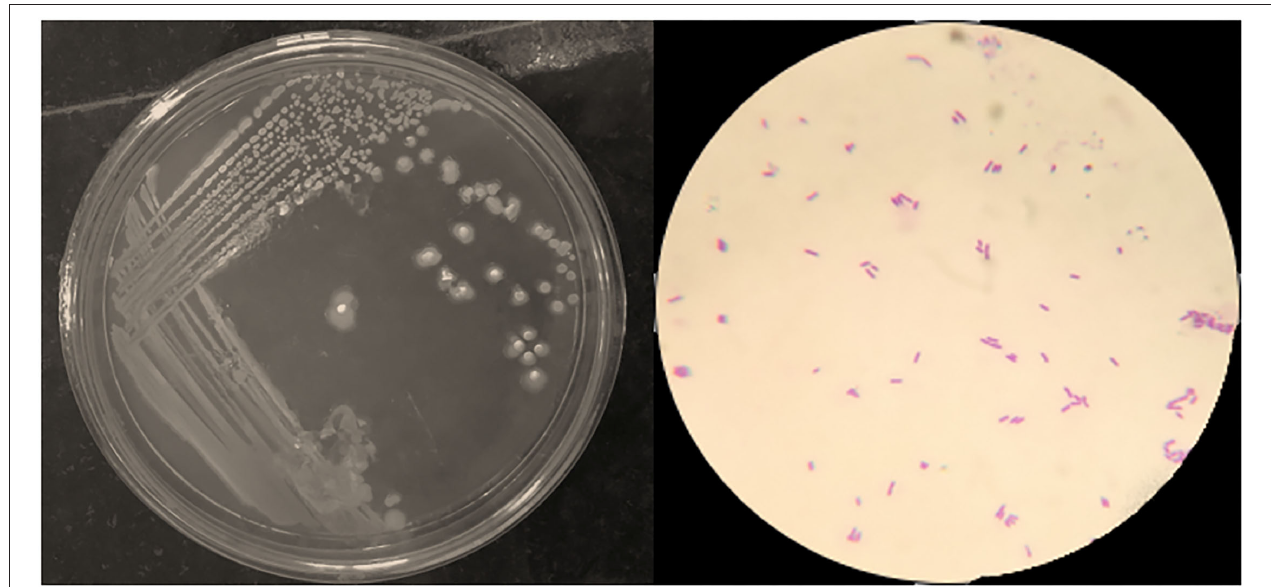
FIGURE 1 | Growth of Bacillus sp. PG-8 on nutrient agar plate and Gram’s staining.